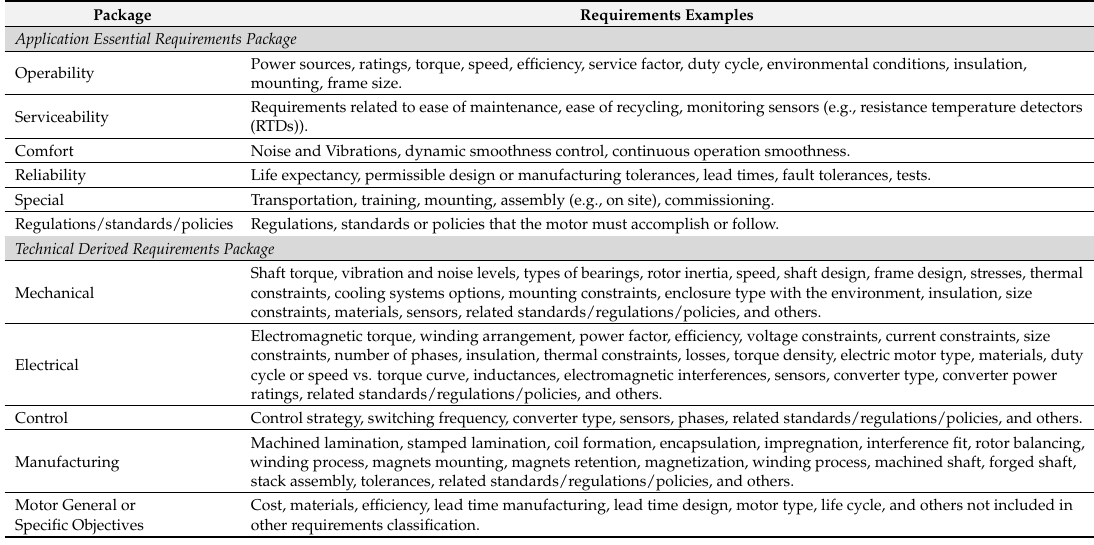
Table 1. Examples of Requirements for each Package.